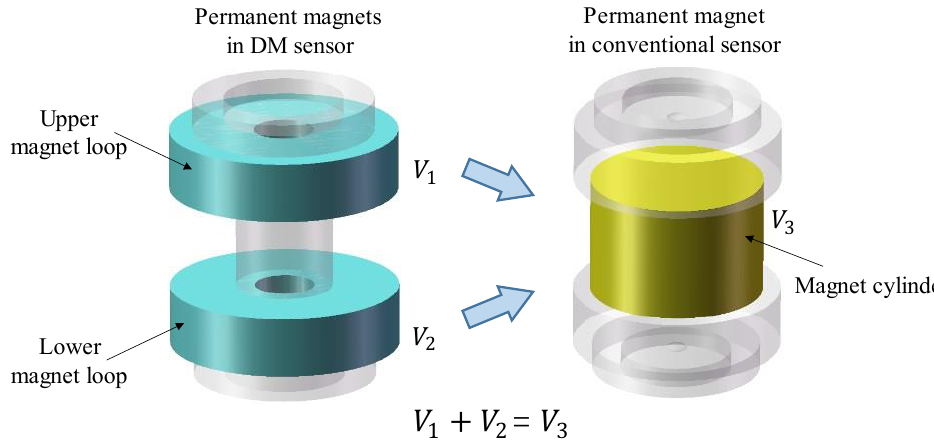
Figure 11. Relationship in volume size of permanent magnets between DM sensor and conven- tional sensor.